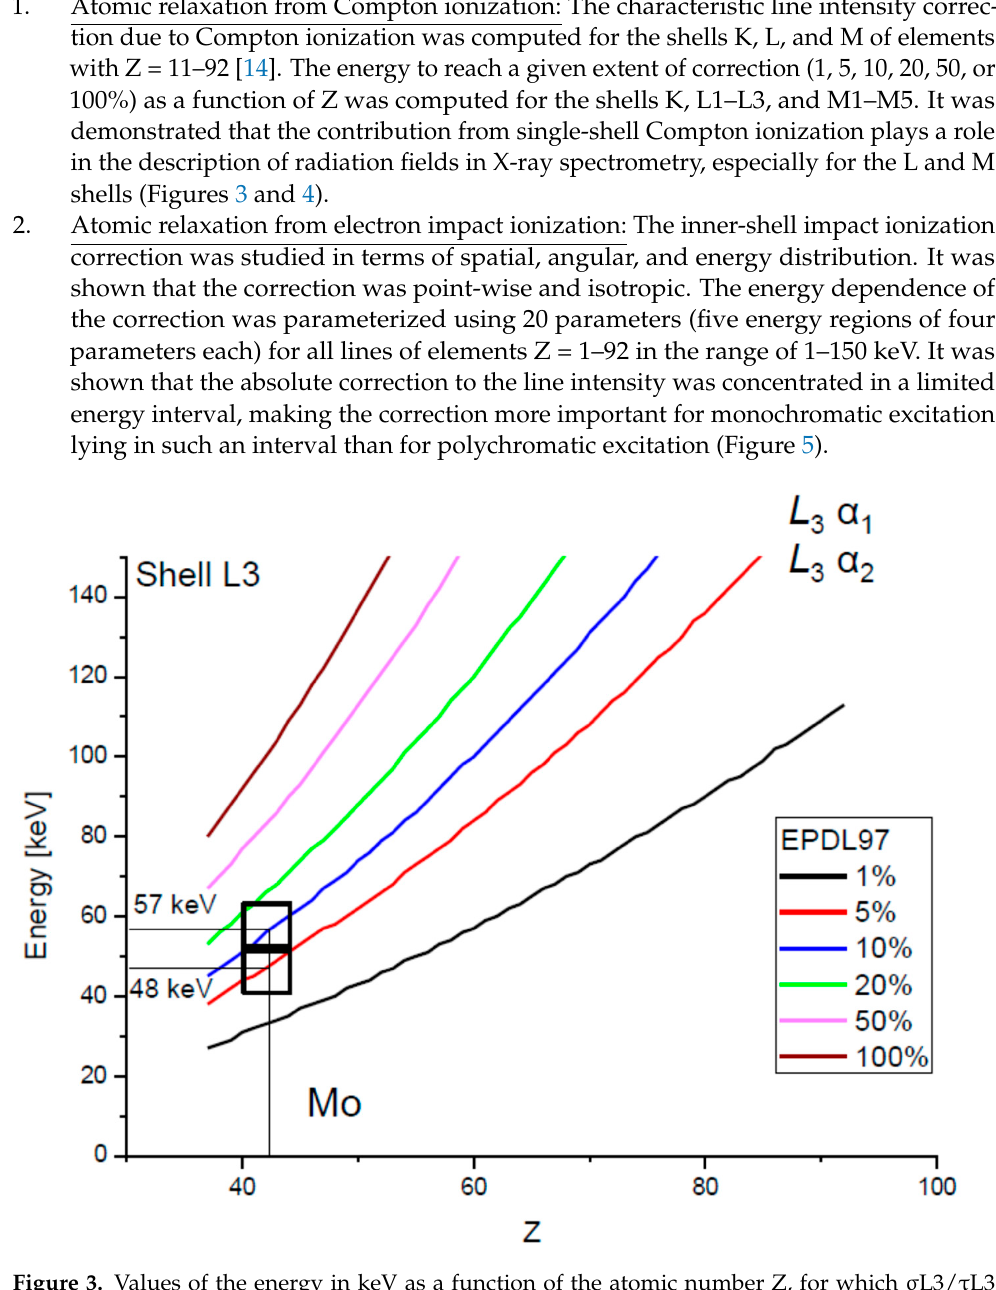
Figure 3. Values of the energy in keV as a function of the atomic number Z, for which σ L3/ τ L3 became larger than 1%, 5%, 10%, 20%, 50%, and 100%. These values were computed using the EPDL97 database. This shows the extent of the correction for the Mo lines of L3, α 1 , and α 2 when the exciting source was around 50